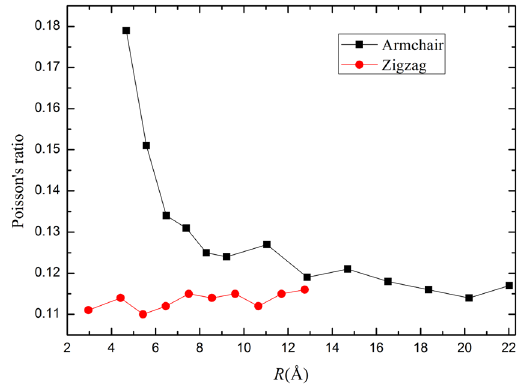
Figure 6. Poisson’s ratio versus radius.